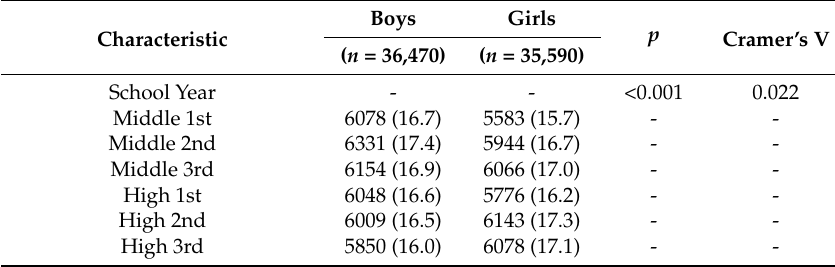
Table 1. General characteristics by sex and smoking status of family and